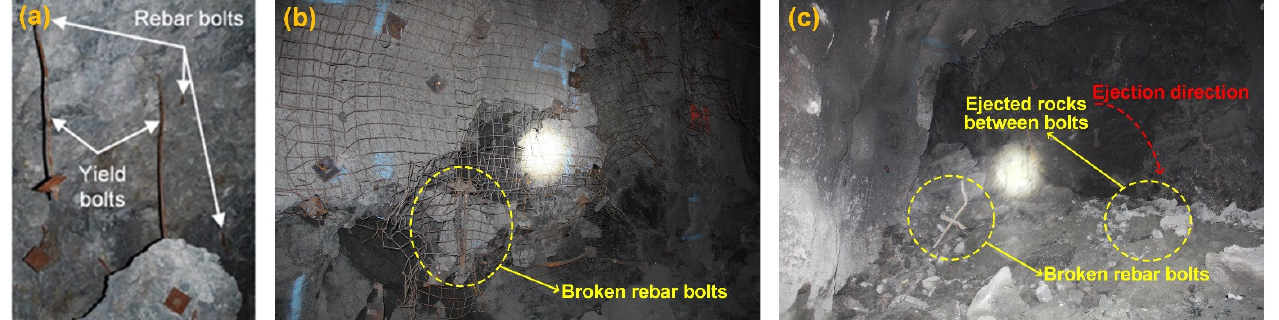
Figure 13. Simulated velocity distribution of the surrounding rock masses along the tunnel supported by different types of rockbolts. ( a ) D-bolt; ( b ) Roofex; ( c ) Resin-grouted rebar.